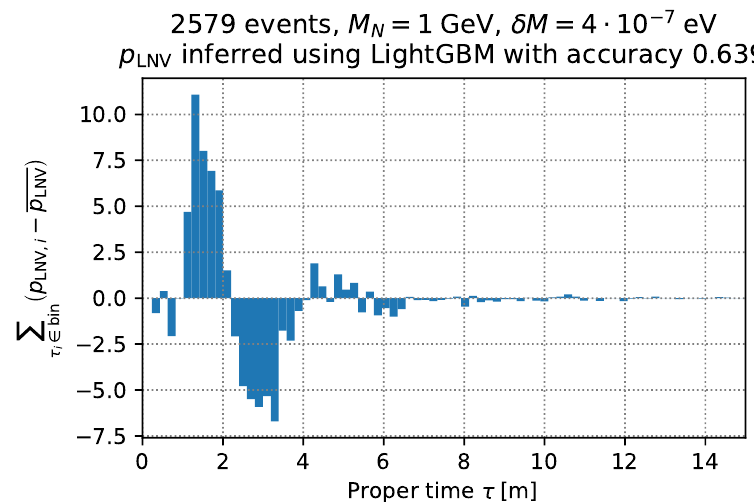
Figure 11. Events binned by proper time (cid:28) and weighted by p pattern, for two HNLs with M 7 4 (cid:1) 10 (cid:0)